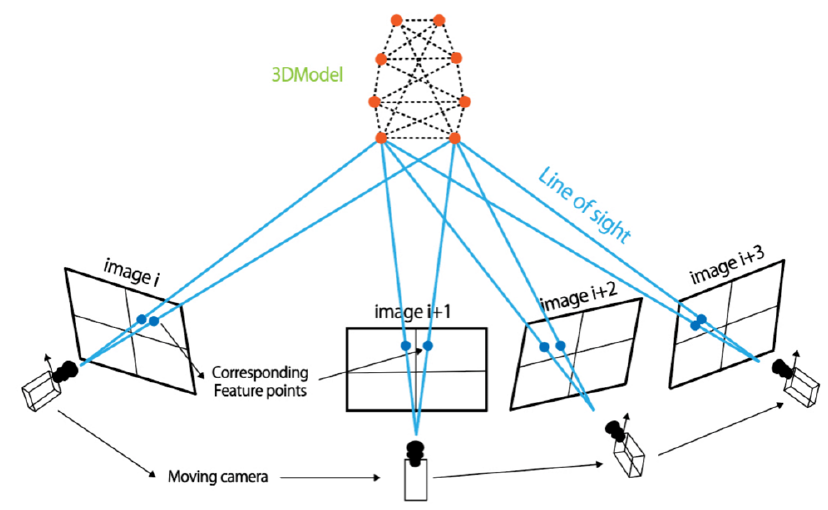
Figure 5. Overview of the SfM method and 3D point group generation.